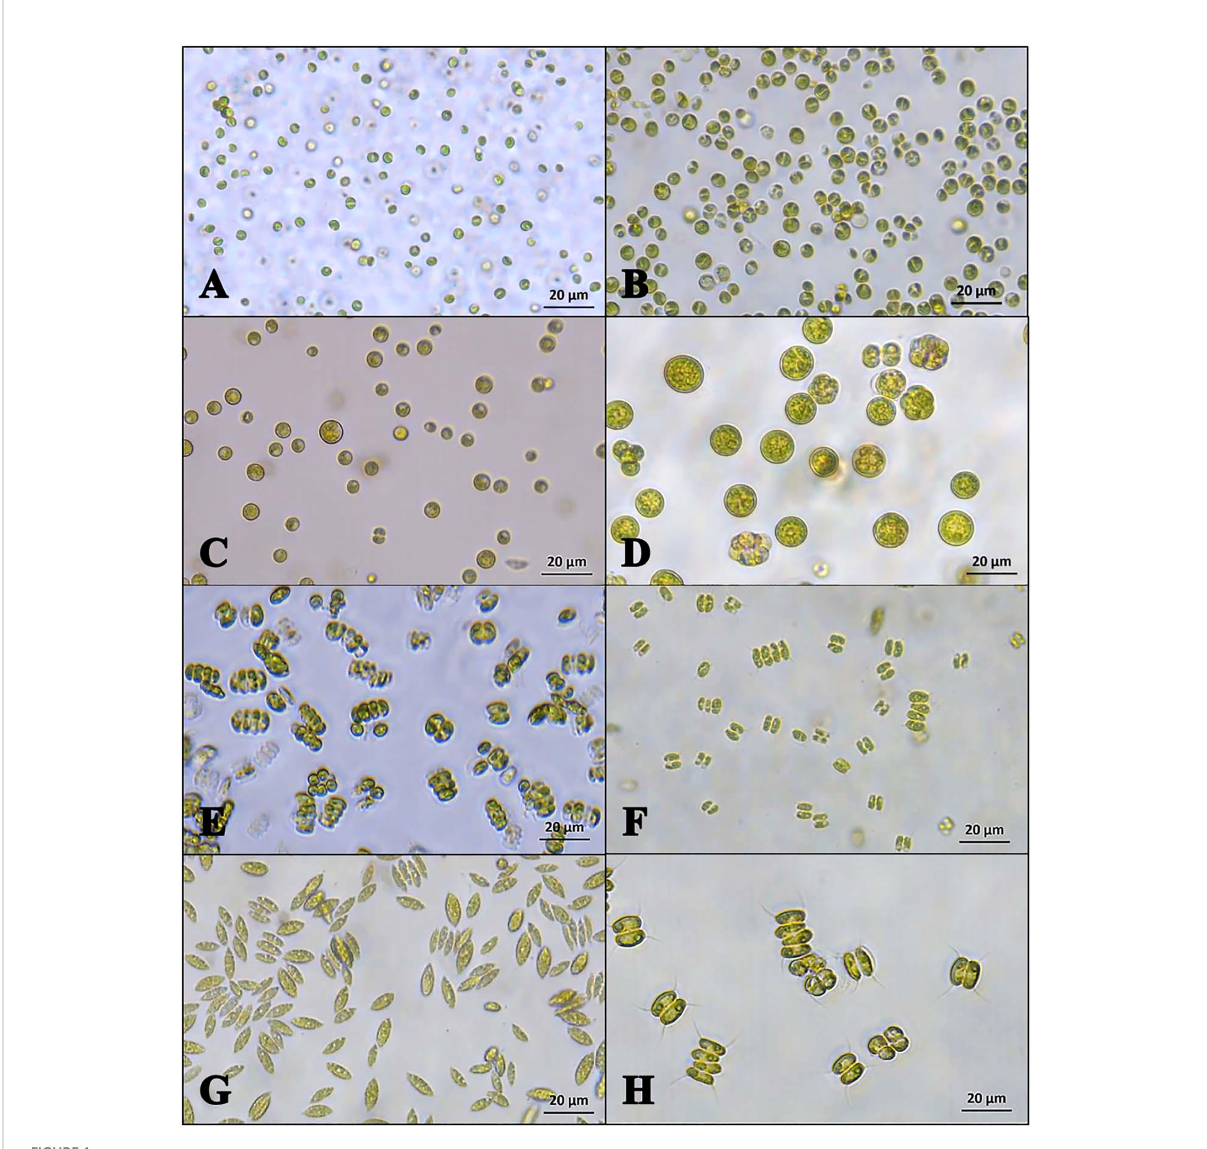
FIGURE 1 Microscopicimagesof microalgae: (A) GlycophilicChlorellaorChlorellasaccharophilus; (B) Chlorellasorokiniana; (C) Chlorellavulgaris; (D) Coelastrella; (E) Desmodesmus; (F) Desmodesmus; (G) Scenedesmusobliquus; (H) Scenedesmus. (reproducedwithpermission from Ferroet al.,